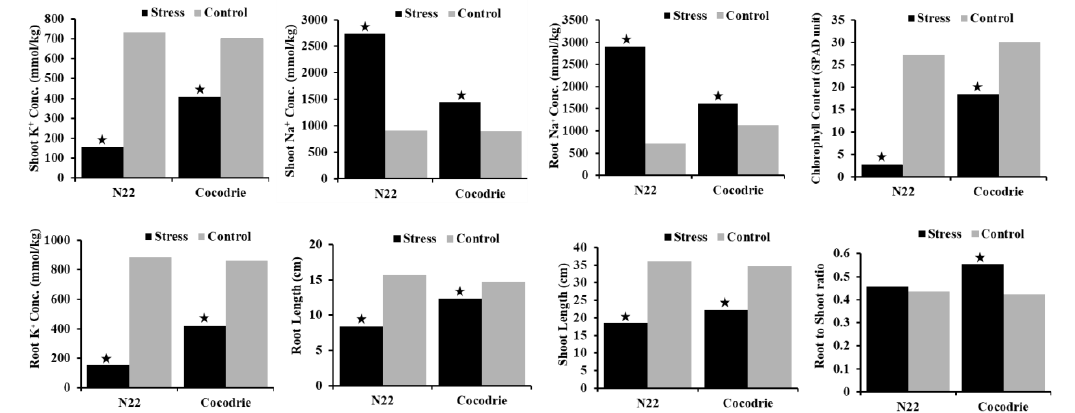
Figure 3. Comparison of Cocodrie and N22 for various physiological and morphological traits under alkaline stress and non-stress environments. Single asterisk indicates significant difference between the means of Cocodrie and N22 for stressed and control environment at 0.05 level of probability.